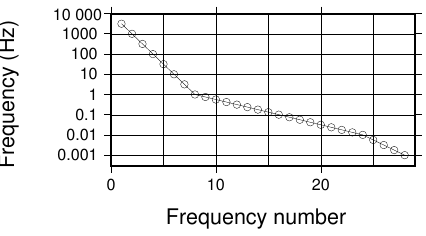
Figure 10. Chart of frequency indices and values used in 3-D in- version process. Frequency spacings per decade were 2 (for 3000– 1Hz), 8 (for 1–0.01Hz), and 4 (for